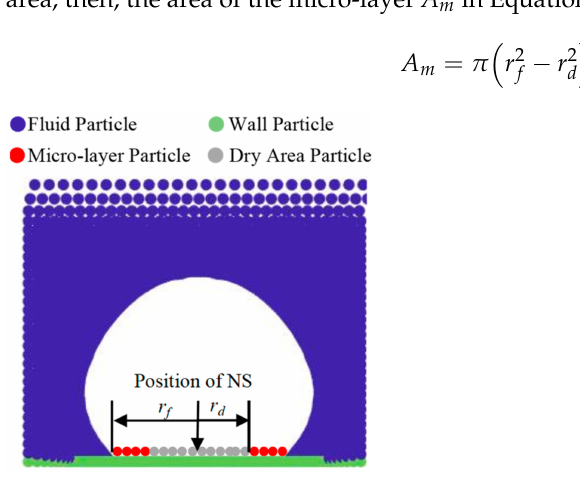
Figure 5. Distribution of micro-layer and dry area during